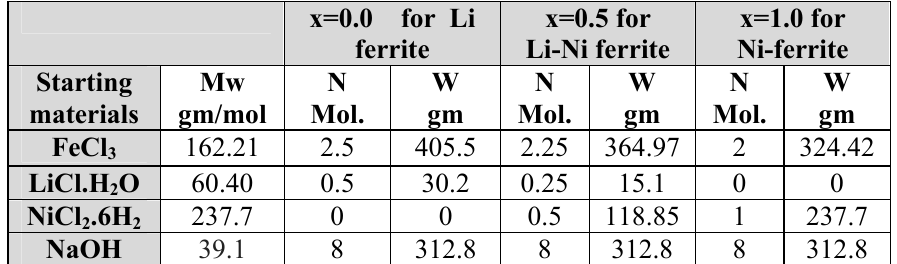
Table 1: Examples of starting material weights for 0.01 mole for Li, for x=0.0, 0.5 and 1.0.Mw: molecular weight in gm/mole, N: no. of mole .